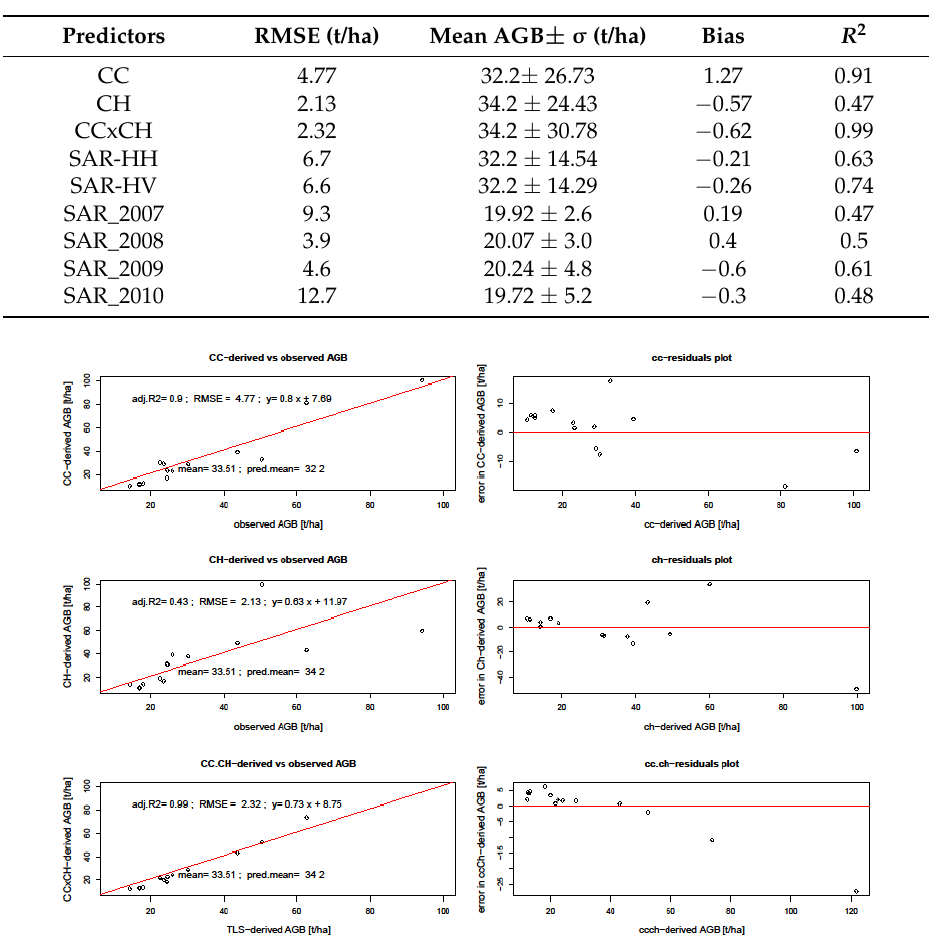
Figure 9. Regression and residual plots between TLS metrics derived AGB and field. CC denotes canopy cover, CH denotes canopy height, and RMSE denotes root mean square